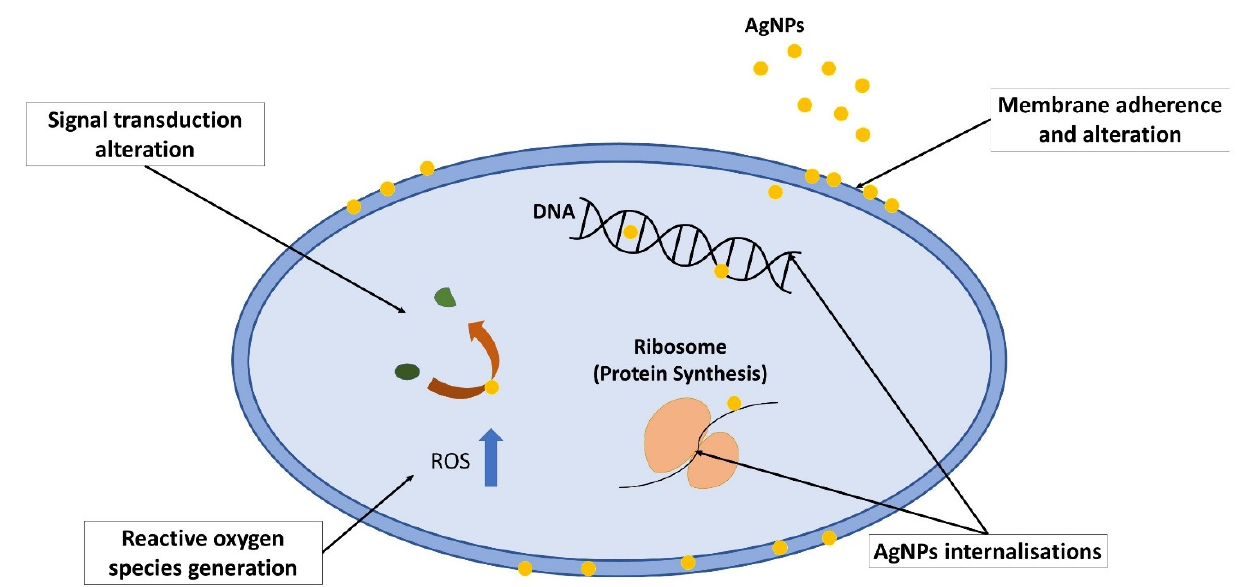
Figure 4. Mechanism of action exhibited by silver nanoparticles on bacteria, which includes mem- brane adherence and alteration, AgNP internalisations, which later induces cellular damage, reactive oxygen species generation, which causes oxidative stress, and signal transduction alteration.